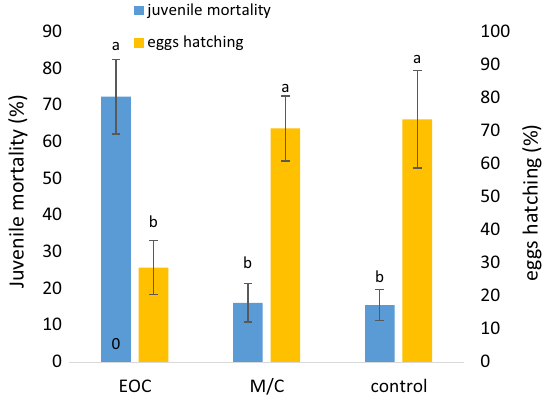
Fig. 3 Effect of extracted nonvolatile compounds on juvenile mortality and egg hatching. After precipitation and separation of proteins and peptides from medium culture of strain AzBw1, remaining medium was used for extraction of nonvolatile organic compounds by ethyl acetate. Ethyl acetate was evaporated and remaining dry compounds were dissolved in chloroform/methanol (2:1 v/v) solution. To check nematicidal activity, 50 µl (containing 5 µg dry compounds) of this solution was placed in each wells of 24‑well plat and left under sterile air stream until dry. Then juvenile or eggs suspensions were added and results were recorded on next days. Pure chloroform/methanol solution was used as negative control. EOC: extracted nonvolatile organic compounds; M/C: chloroform/ methanol solution. Values followed by the same letter are not significantly different at 1%, as determined by analysis of variance followed by Fisher’s test. Bars indicate standard error. This experiment was conducted twice with the same